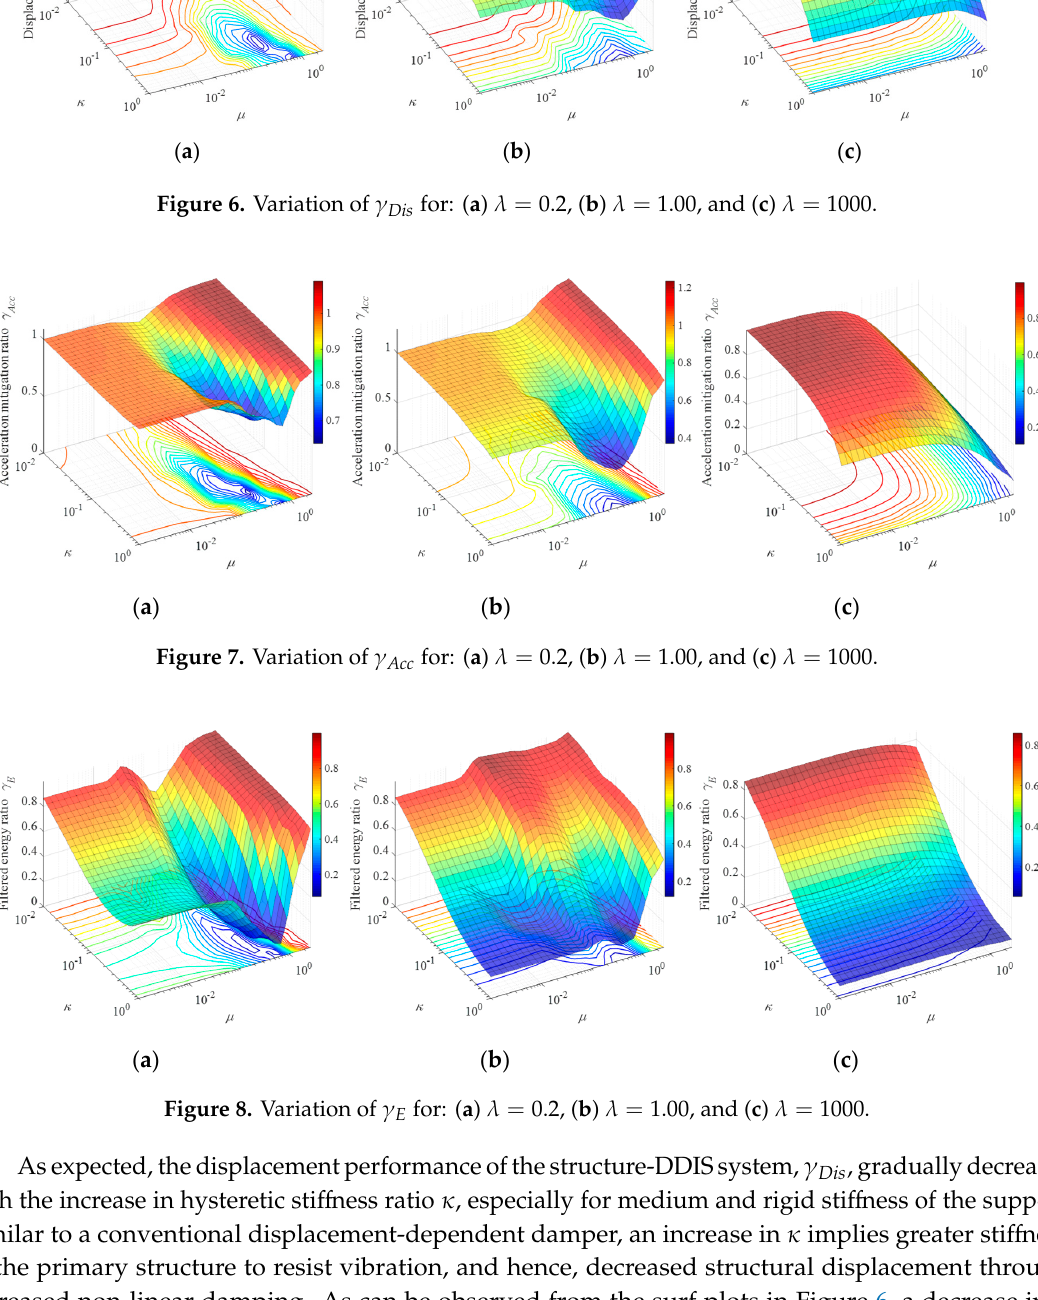
Figure 8. Variation of γ for: (a) λ= 0.2 , (b) λ= 1.00 , and (c) λ= 1000 . E